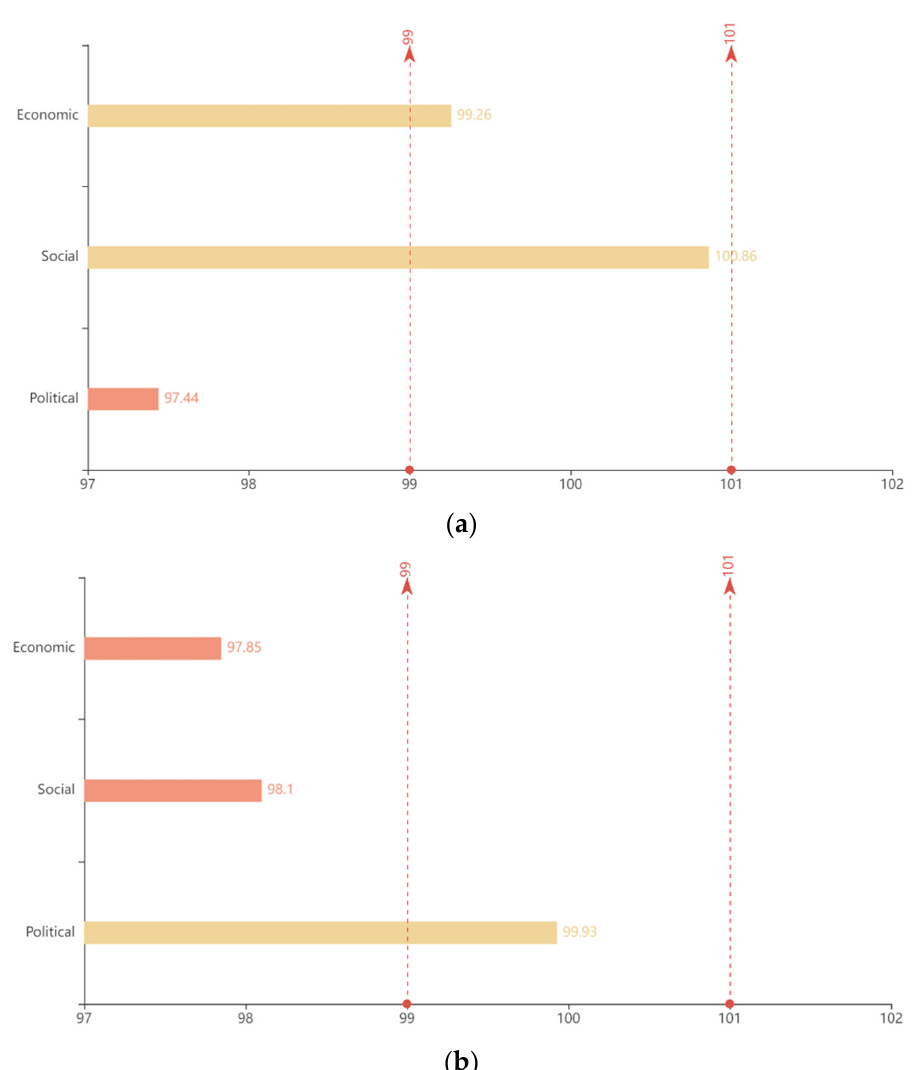
Figure 5. Three-dimensional forces of globalization barometer. ( a ) Three-dimensional forces of de facto globalization barometer. ( b ) Three-dimensional forces of de jure globalization barometer.